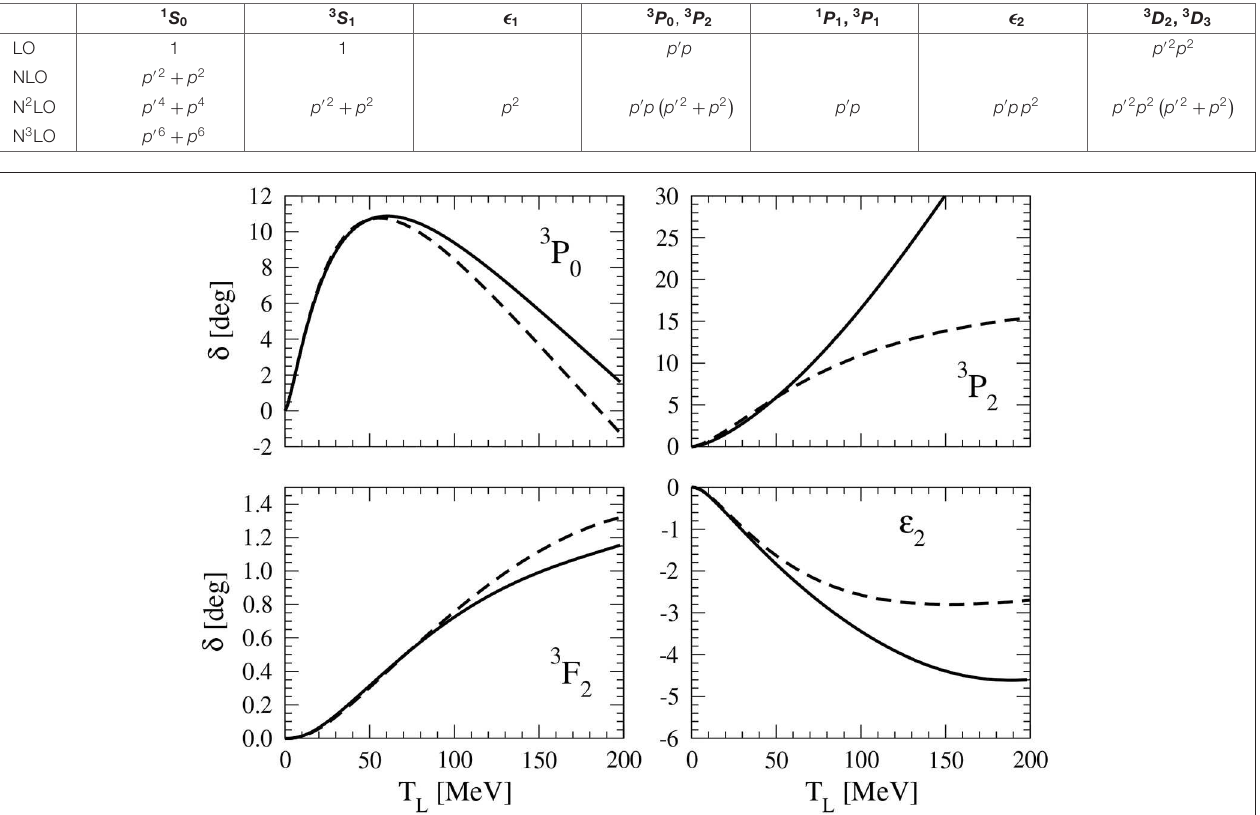
TABLE 3 | Schematic momentum dependence of the lowest-order contact interactions in the 2 N system up to D waves, according to references [20, 31, 62, 68, 104, 105].